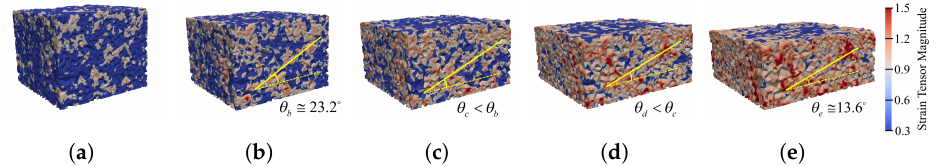
Figure 17. The micro-strain contour evolution during the compaction process of specimen S 9 , ( a ) (cid:101) 3 = 0.1, ( b ) (cid:101) 3 = 0.2, ( c ) (cid:101) 3 = 0.3, ( d ) (cid:101) 3 = 0.4, ( e ) (cid:101) 3 =